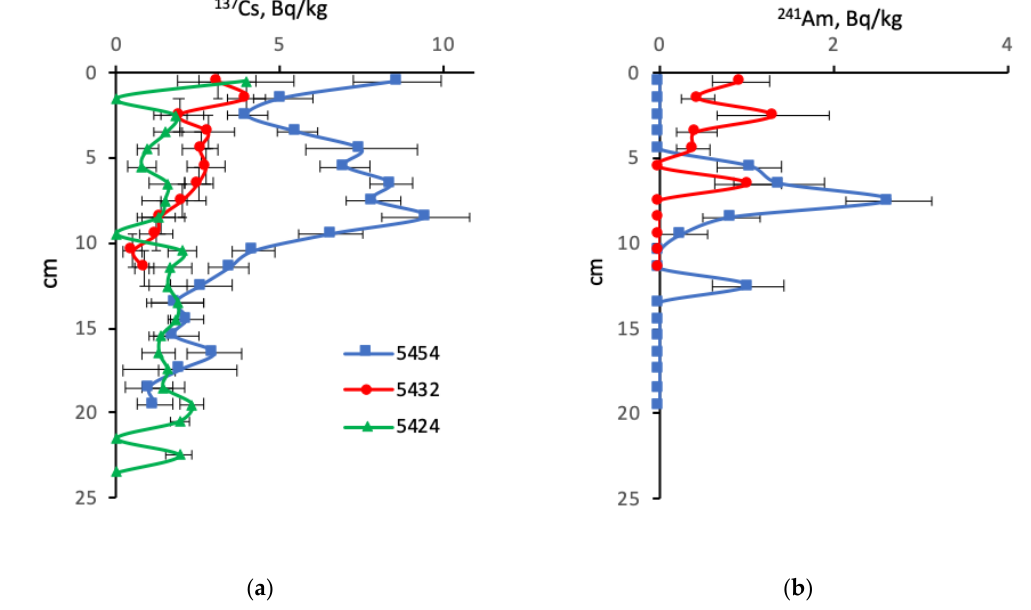
Figure 6. Downcore distribution of 137 Cs ( a ) and 241 Am ( b ) from AMK-5424, -5432, and -5454 cores.